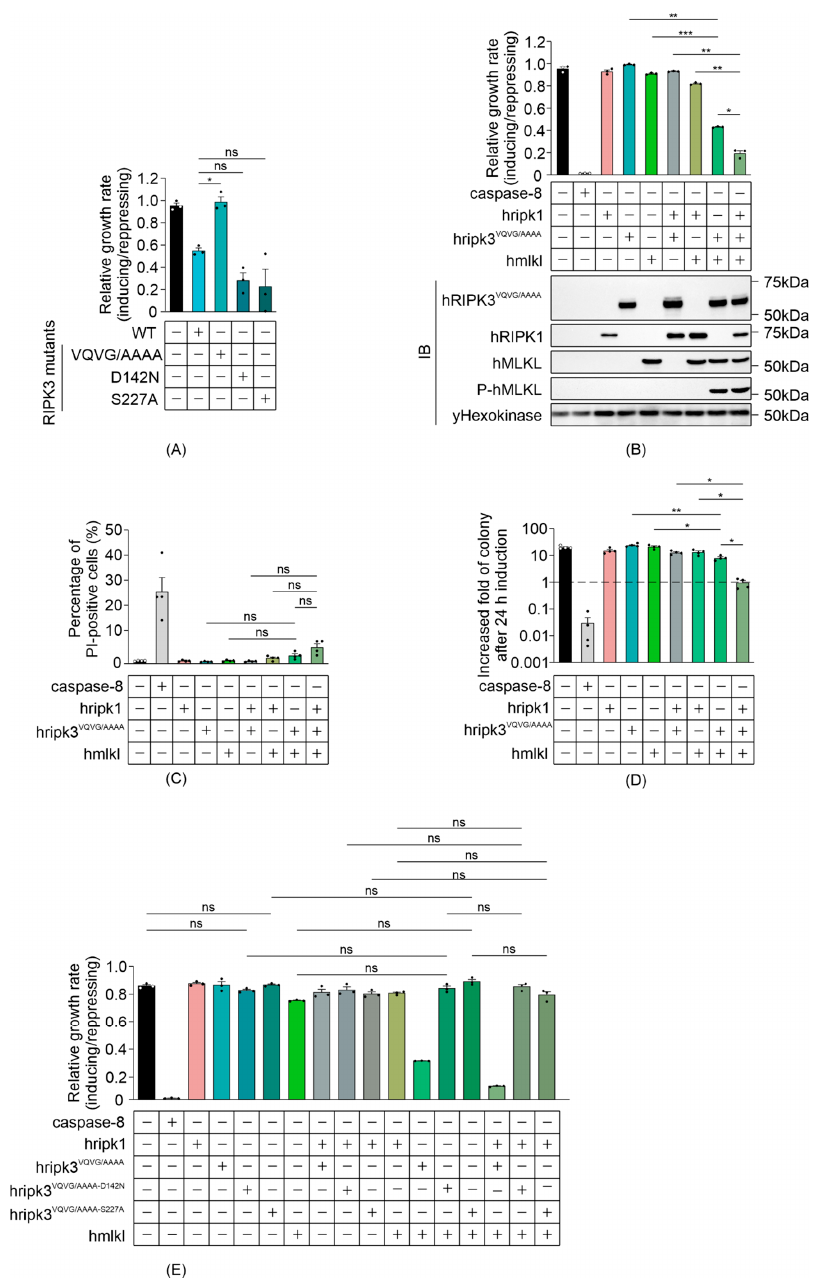
Figure 2. Reconstitution of necrosome interactions using RHIM-mutated RIPK3 in S. cerevisiae . Maximal growth rates of yeast-bearing expression plasmids encoding ( A ) human wild type and mutated RIPK3 proteins, or ( B , E ) human wild type MLKL, RIPK1 and/or RIPK3 VQVG/AAAA , RIPK3 VQVG/AAAA-D142N or RIPK3 VQVG/AAAA-S227A , were analyzed by monitoring changes in absorbance of yeast cultured in inducing and repressing liquid media. ( C ) Yeast bearing expression plasmids encoding human wild-type MLKL and/or RIPK1, and/or RIPK3 VQVG/AAAA were grown under inducing conditions for 24 h. Plasma membrane integrity of each yeast culture was assessed by propidium iodide (PI) uptake. ( D ) The clonogenic abilities of yeast transformants were evaluated by determining colony-forming ability of the culture relative before and after transgene induction for 24 h. Data present mean ± SEM of three ( A , B , E ) or four ( C , D ) independent assays. ( A ) Differences in growth rates of yeast expressing wild type RIPK3 and those expressing each mutated RIPK3 transgene were compared using ANOVAs with Sidak corrections. ( B – E ) Statistical analysis of differences in growth rates, membrane integrity and clonogenic ability between transformants expressing sets of 2–3 transgenes versus individual transgenes or pairs of transgenes were calculated using ANOVAs with Sidak corrections. *, p < 0.05; **, p < 0.01; ***, p < 0.001; ns, not